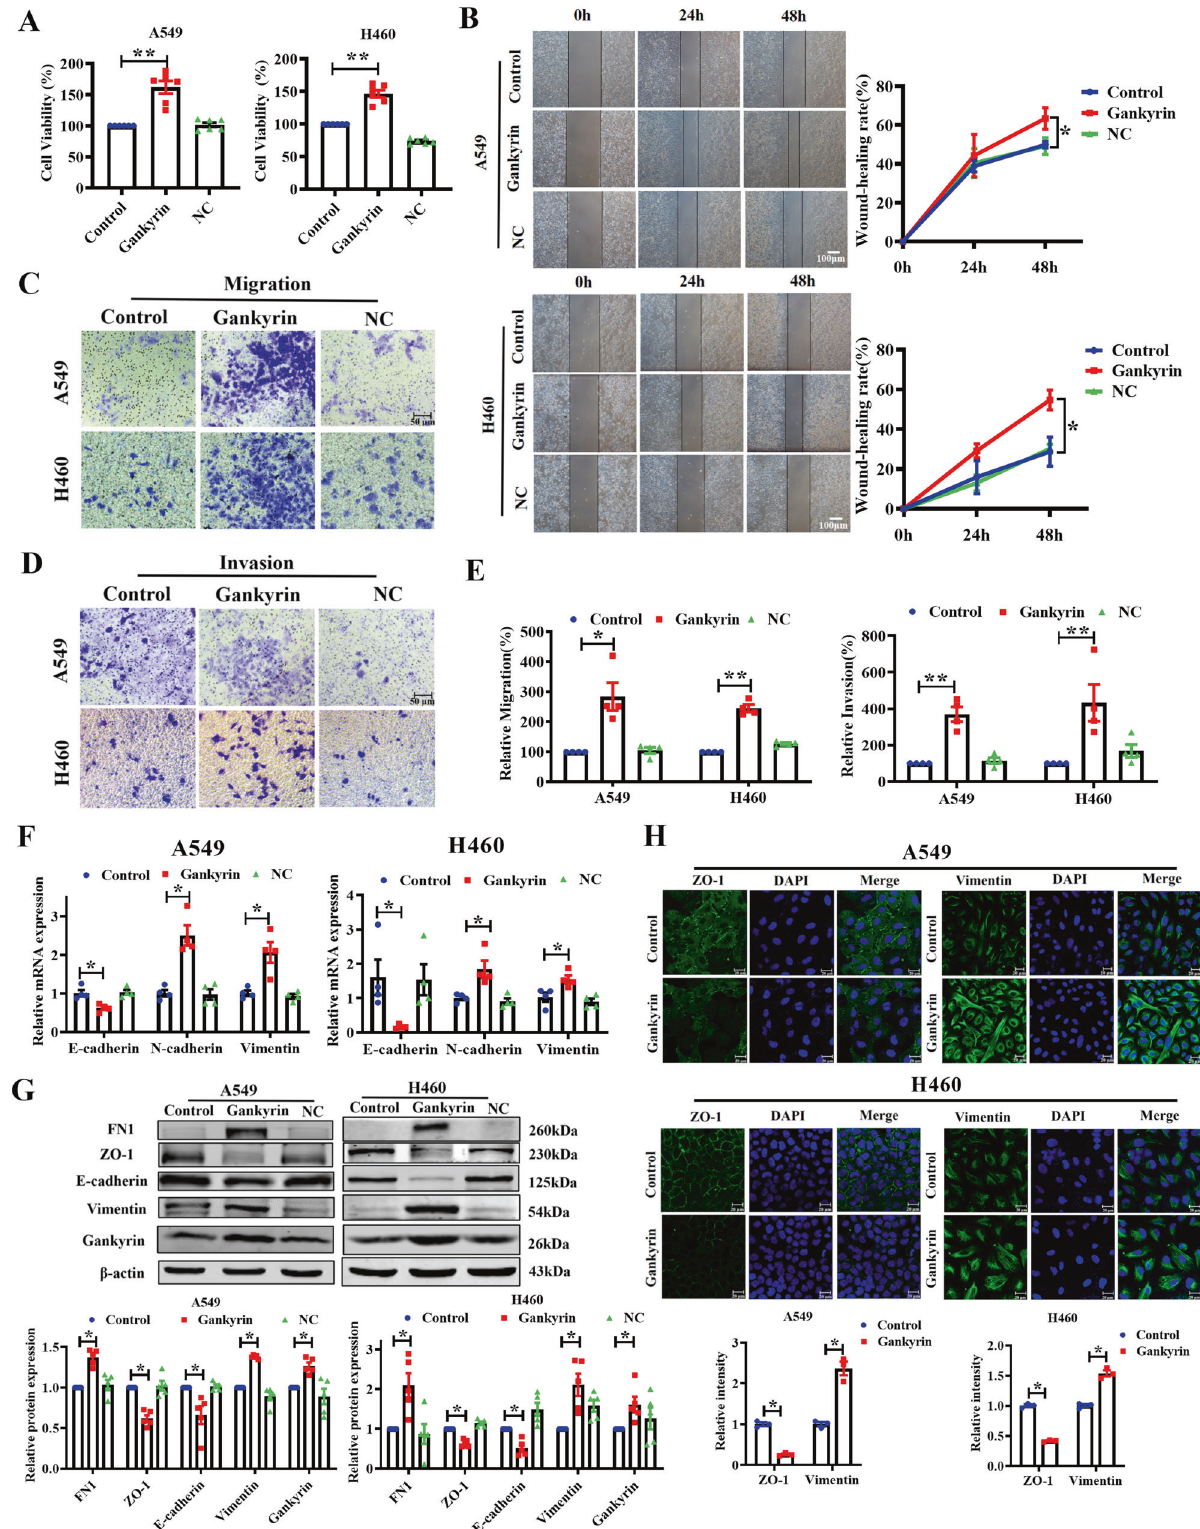
Fig. 2 Overexpression of Gankyrin promotes NSCLC cell proliferation, migration, invasion, and EMT. A MTT assay was used to detect the viability of the NSCLC cells A549 and H460 ( n = 6, ** P < 0.01). B Wound-healing assays demonstrated the migration ability of A549 and H460 cells ( n = 5, * P < 0.05. Scale bars: 100 μ m). C , D Migration and invasion experiments performed for A549 and H460 cells through transwell assay (Scale bars: 50 μ m). E Statistical analysis of migration and invasion assay ( n = 4, * P < 0.05, ** P < 0.01). F qRT-PCR assay showed that the mRNA level of EMT-relevant markers in A549 and H460 cells ( n = 4, * P < 0.05). G Western blotting assay showed the protein expression of EMT-relevant markers in A549 and H460 cells ( n = 5, * P < 0.05). H Immuno fl uorescence assay was used to detect the Vimentin and ZO - 1 in A549 and H460 cells with the overexpression of Gankyrin (Scale bars: 20 μ m). Vimentin and ZO-1 intensity assays were shown at the bottom of the image ( n = 3, * P < 0.05). Cell Death Discovery (2022)